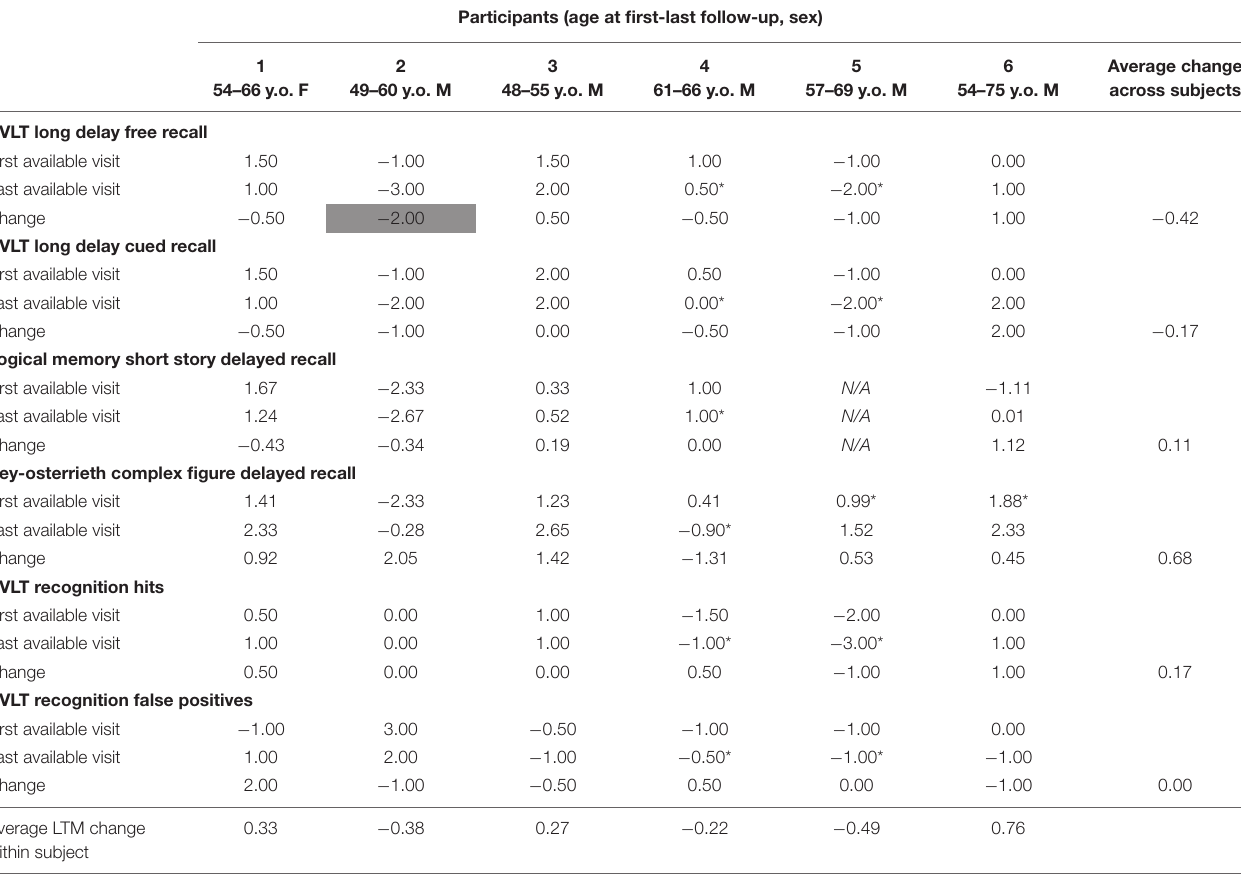
TABLE 4 | Long-term memory (LTM) performance of the sample.